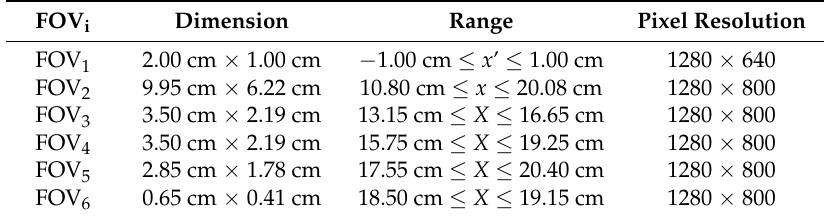
Table 1. A list of dimension, range, and pixel resolution for each field of view, FOV i (i = 1–6).